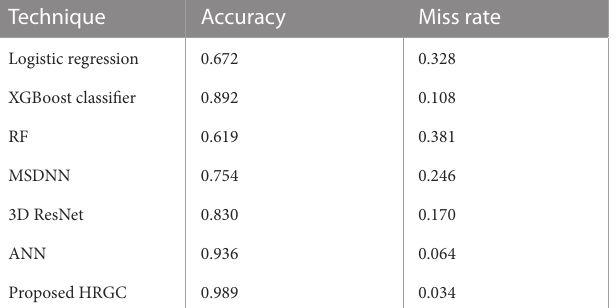
TABLE5 Performancecomparisonofaccuracyandmissrate(Khan et al.,2021).